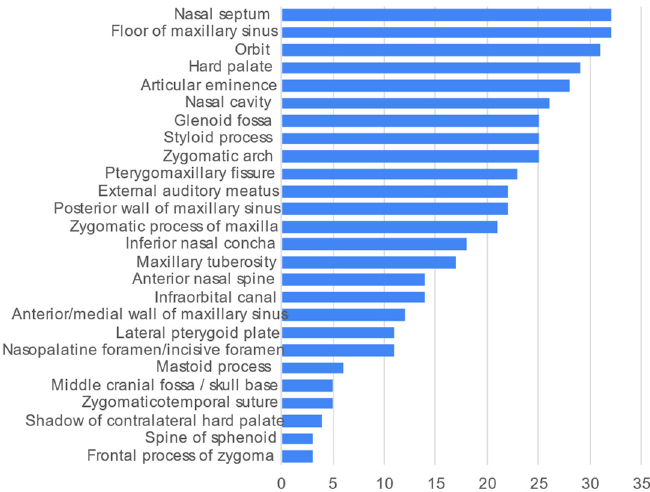
Figure 4. Frequency count of midfacial anatomical landmarks commonly described in the 38 videos.